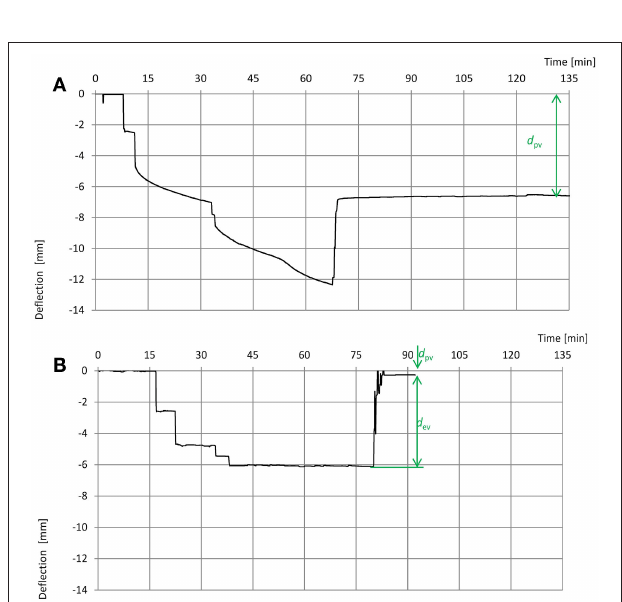
FIGURE 5 | Registered extreme beam deflections in time history: (A) during the first test load; (B) during the test load conducted after the repair. Elastic d ev and permanent d pv deflection values are